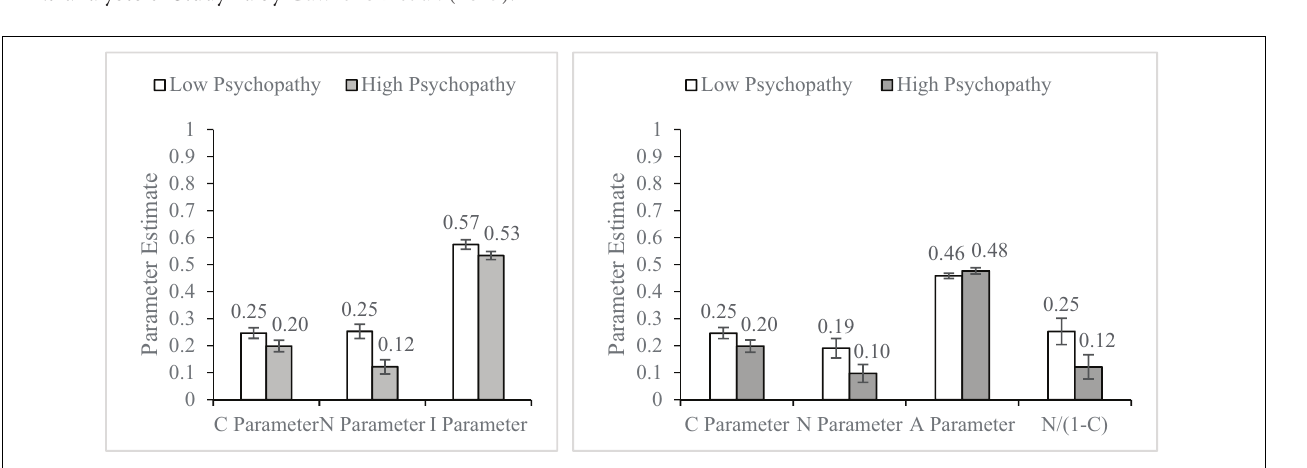
FIGURE A5 | Results of Study 4a by Gawronski et al. (2017) obtained from the CNI model (left) and CAN algorithm (right) . Error bars represent ± 1 SE.